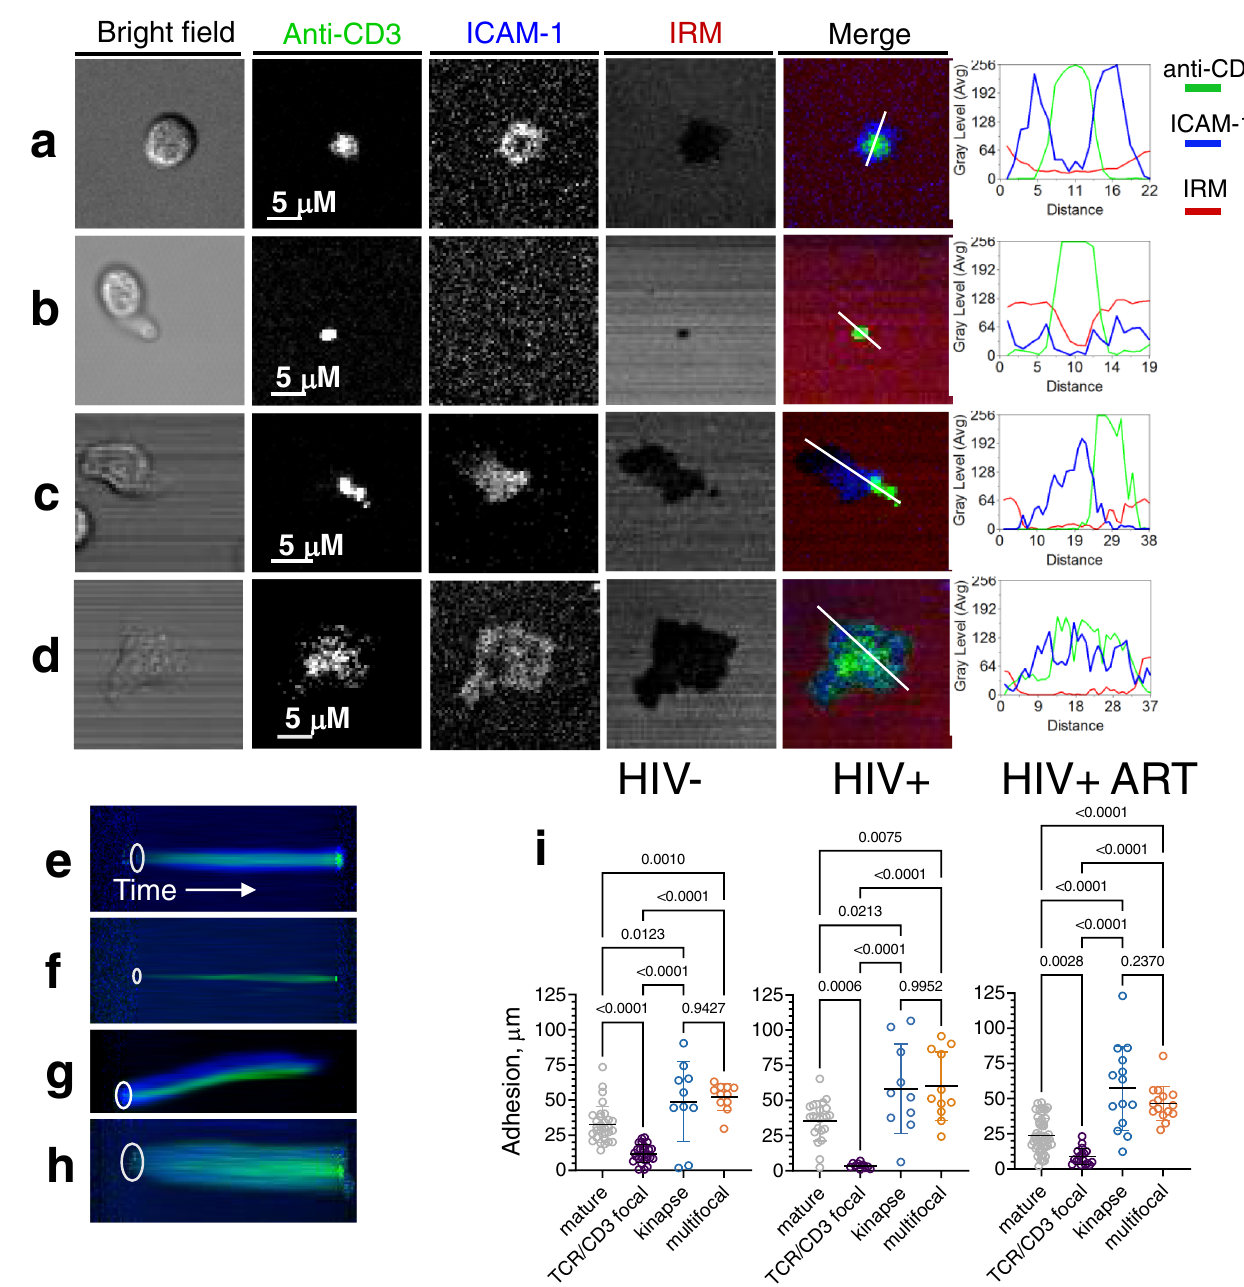
Fig.1|HumanpolyclonalCD8Tcellsestablishdiversesynapticinterfaceswith lipid bilayers that display labeled anti-CD3 antibody and ICAM-1 ligands. The images were taken by confocal microscope every 2min over 30min. Representa- tiveimagesofTcell-bilayerinterfacetakenattheendoftheobservationperiodare shown: mature synapse ( a ), TCR/CD3 focal synapse ( b ), kinapse ( c ) and multifocal synapse ( d ). IRM images show contacts of CD8 T cells with the bilayer surface as darkareaonlightbackground.Histogramsdepictthe fl uorescentintensitypro fi les along the diagonal white lines in overlay images. Distance is measured in pixels. Blue: ICAM-1, green: anti-CD3, red: IRM. Scale bars: 5 μ m. Representative kymo- graphs show temporal changes in spatial position of ICAM-1 (blue) and anti-CD3 antibodies(green):maturesynapse( e ),TCR/CD3focalinterface( f ),kinapse( g )and multifocalsynapse( h ).Whiteovalindicatesthepositionofthecell/bilayerinterface